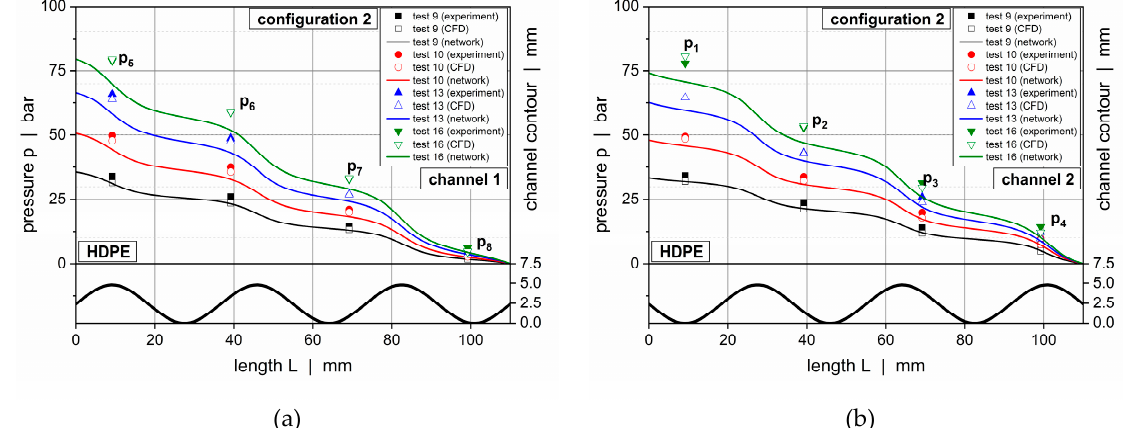
Figure 20. Comparison between experimental data and calculated solutions (seminumerical approach based on network theory vs CFD simulation) for selected operating conditions. Downchannel pressure profiles along channel 1 ( a ) and channel 2 ( b ) for HDPE and configuration 2.